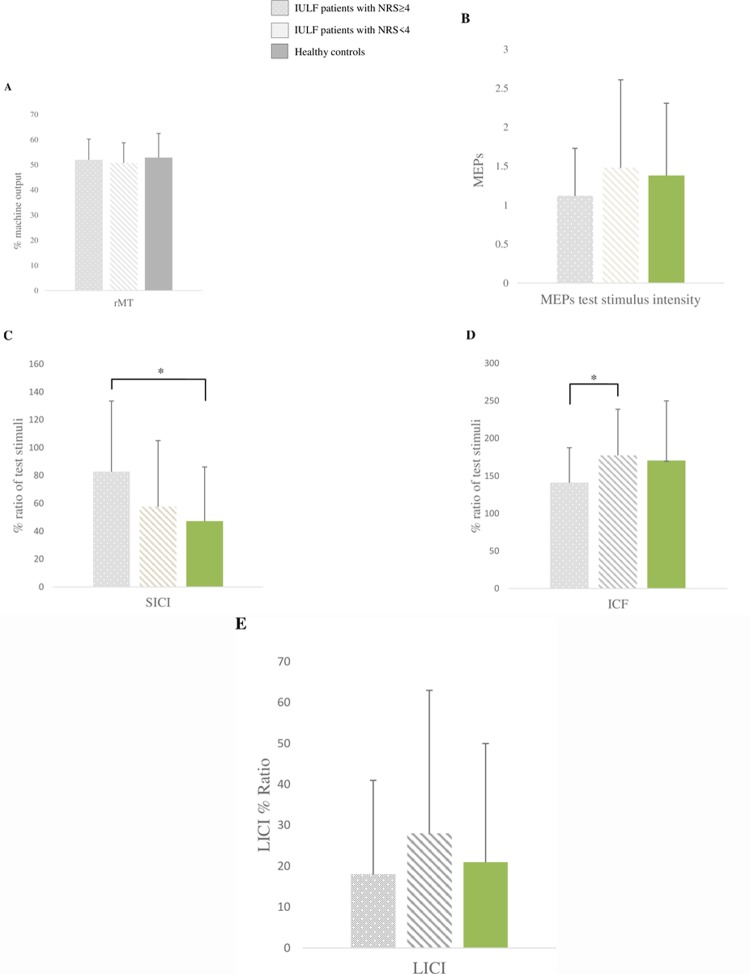
Groups differences on TMS measures.A. Between group comparison on rMT. B. Between group comparison on MEPs test stimulus intensity. C. Between group comparison on SICI. D. Between group comparison on ICF. E. Between group comparison on LICI.